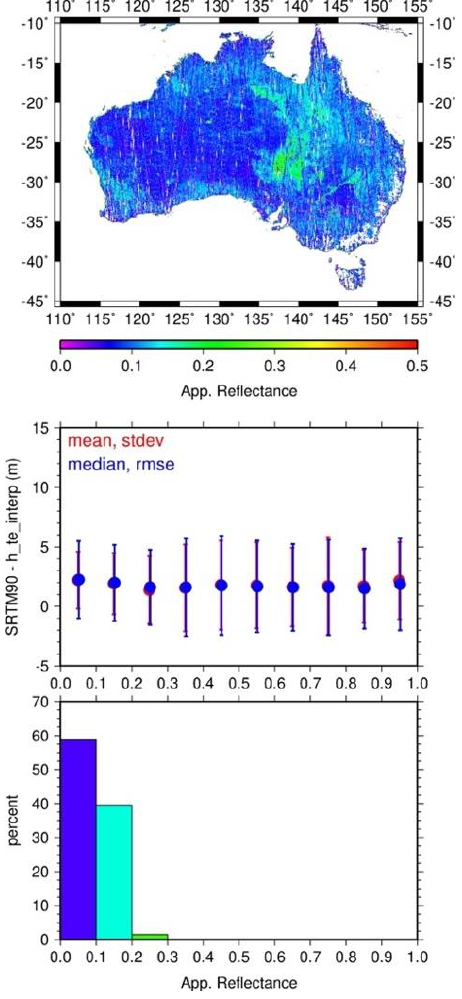
Figure 5. Differences between SRTM 90 m and ATL08 h_te_interp (in m) with respect to Apparent Surface Reflectance ( asr ) for h_te_uncertainty less or equal to 7.5 m and %Tree cover less or equal to 5%. Mean, Median, Standard Deviations and RMSE are shown for asr using 0.1 bin increments.